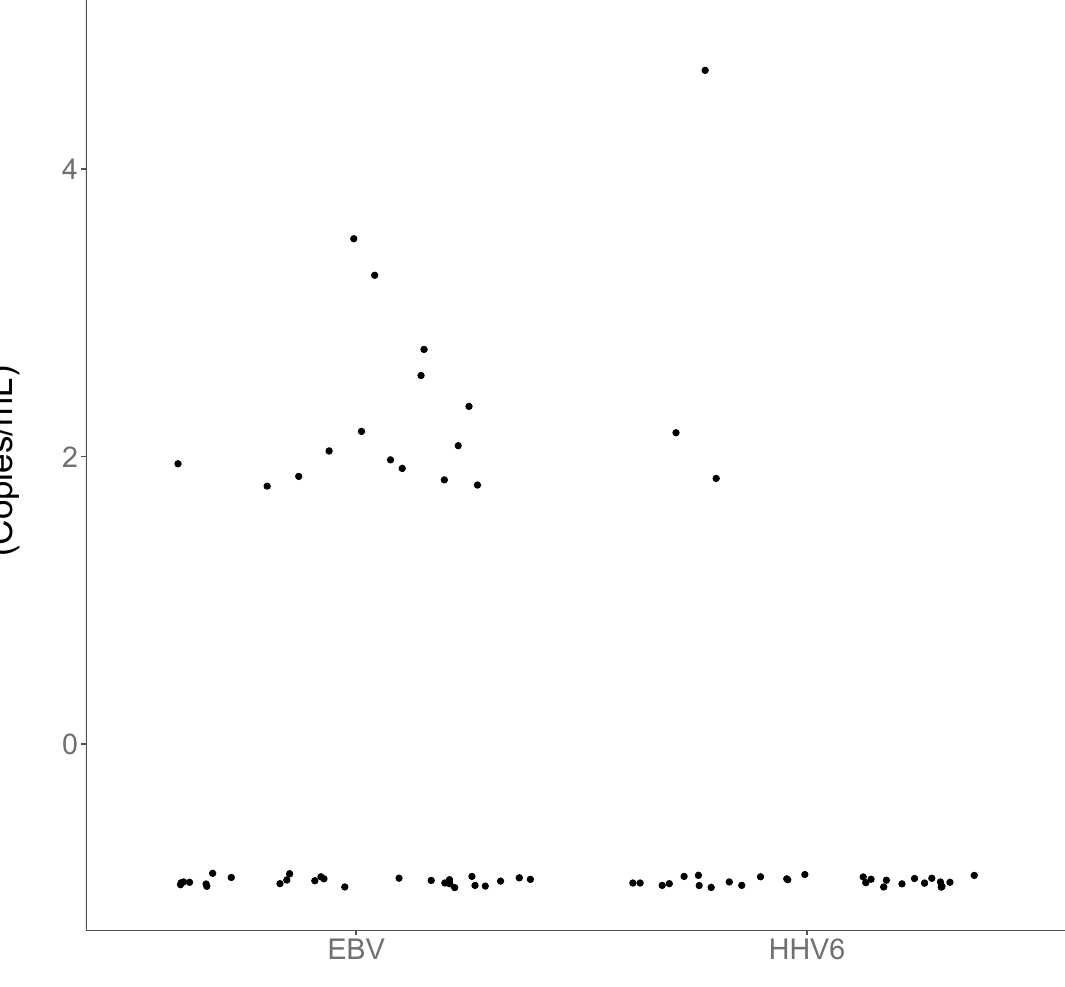
Figure 1. EBV and HHV-6 viral load values. The figure presents the viral load values (log 10 copies/mL) for the patient samples studied. (An arbitrary 0.1 was added to all values prior to log transformation to obviate very large negative log values for results close to 0.)